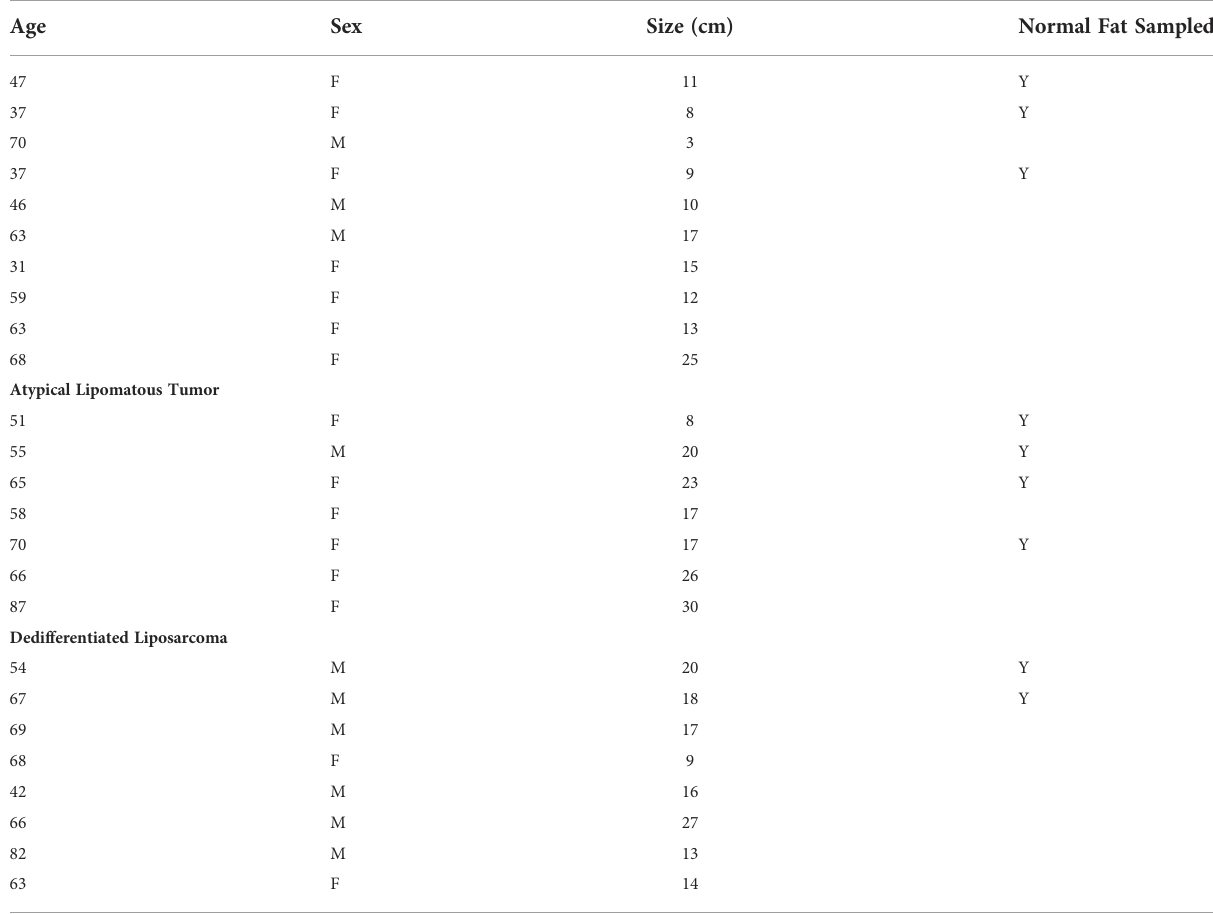
TABLE 1 Patient age, sex, associated pathology, and lesion size. Lipoma